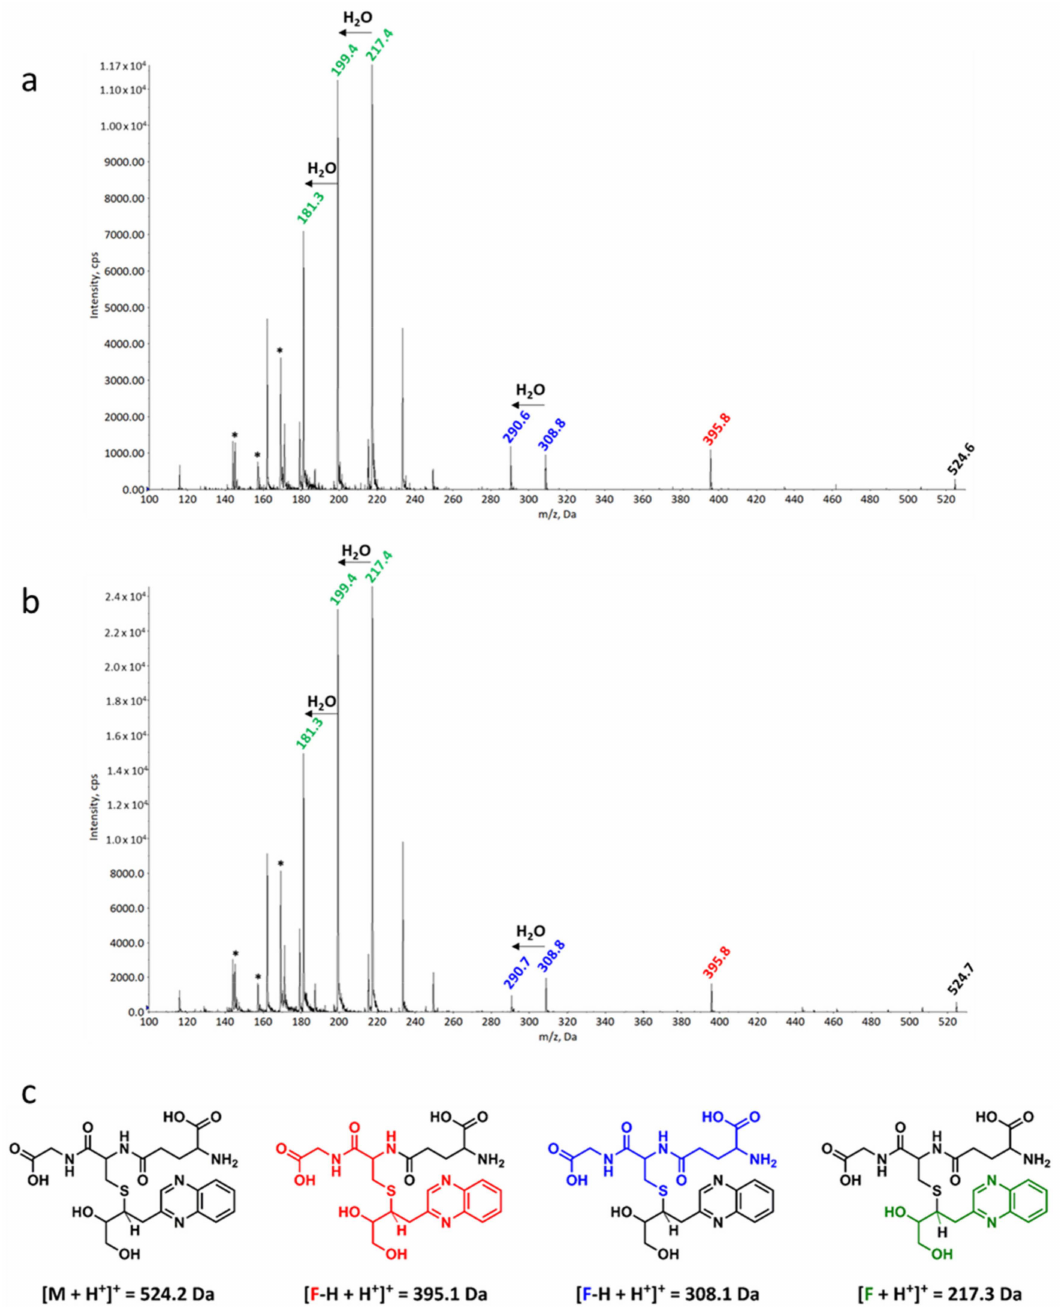
Figure 4. Signals identified as quinoxaline derivatives of a 3,4-dideoxyglucosone-3-ene – L - glutathione (3,4-DGE-GSH) monoadduct. Enhanced product ion (EPI) spectra gained through fragmentation of ( a ) the parent ion ( m/z 524.6 Da) at a retention time of 4.42 min and ( b ) the parent ion ( m/z 524.7 Da) at 5.18 min are shown, including experimental m/z values of the identified frag- ments (as well as after the loss of water molecule(s)) above their respective signal. ( c ) The proposed molecular structures of the adduct and its fragments are depicted together with their theoretical m/z values. The hyphen “-” between the fragment (F) and the hydrogen (H) symbolizes a bond between these. Fragments derived from the 3,4-DGE Qx -backbone are labeled with asterisks. Stereocenters are omitted for